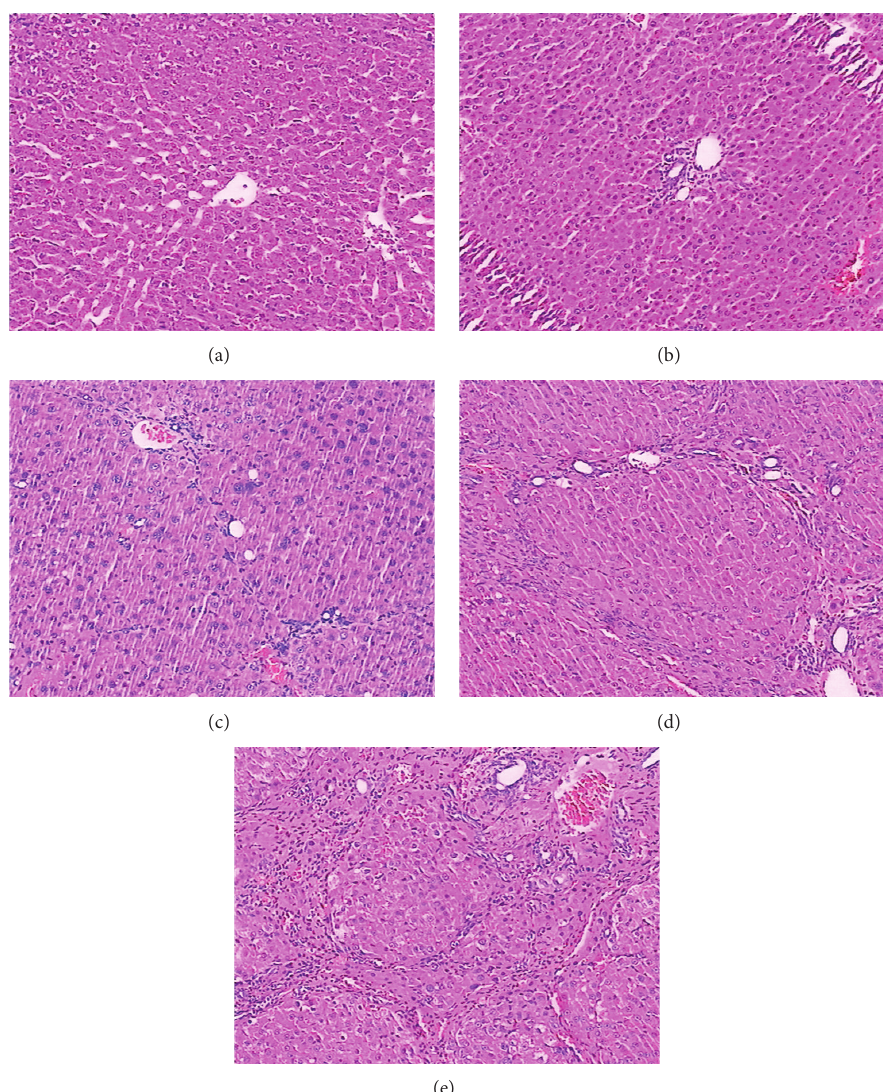
Figure 1: Hematoxylin and eosin staining of the liver tissues. (a) Control group, (b) week 4, (c) week 6, (d) week 8, and (e) week 10 after CCl4